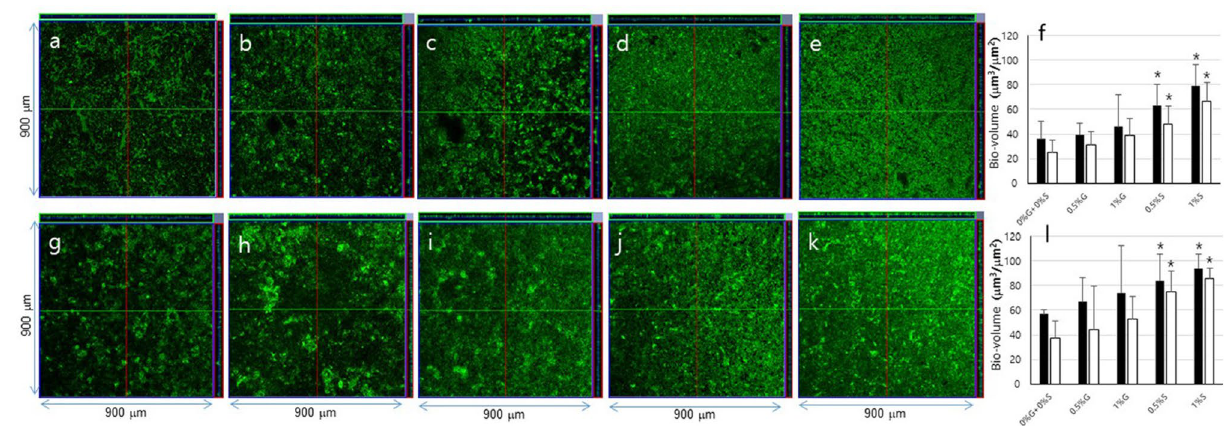
Figure 3. CLSM images of E. faecalis ( a – e ) ATCC29212 and ( g – k ) OG1RF biofilms. The bacteria were grown in 0% glucose + 0% sucrose (0%G + 0%S), 0.5% glucose (0.5%G), 1% glucose (1%G), 0.5% sucrose (0.5%S), or 1% sucrose (1%S). Bio-volume of bacteria (black) and EPS (white) of ATCC29212 ( f ) and OG1RF ( l ) biofilms were quantified by COMSTAT software (COMSTAT2, www.comst at.dk; Technical University of Denmark, Kongens Lyngby, Denmark). Data represent the mean and standard deviation of 3 independent experiments. Asterisks denote a statistically significant difference compared to 0%G + 0%S ( p <